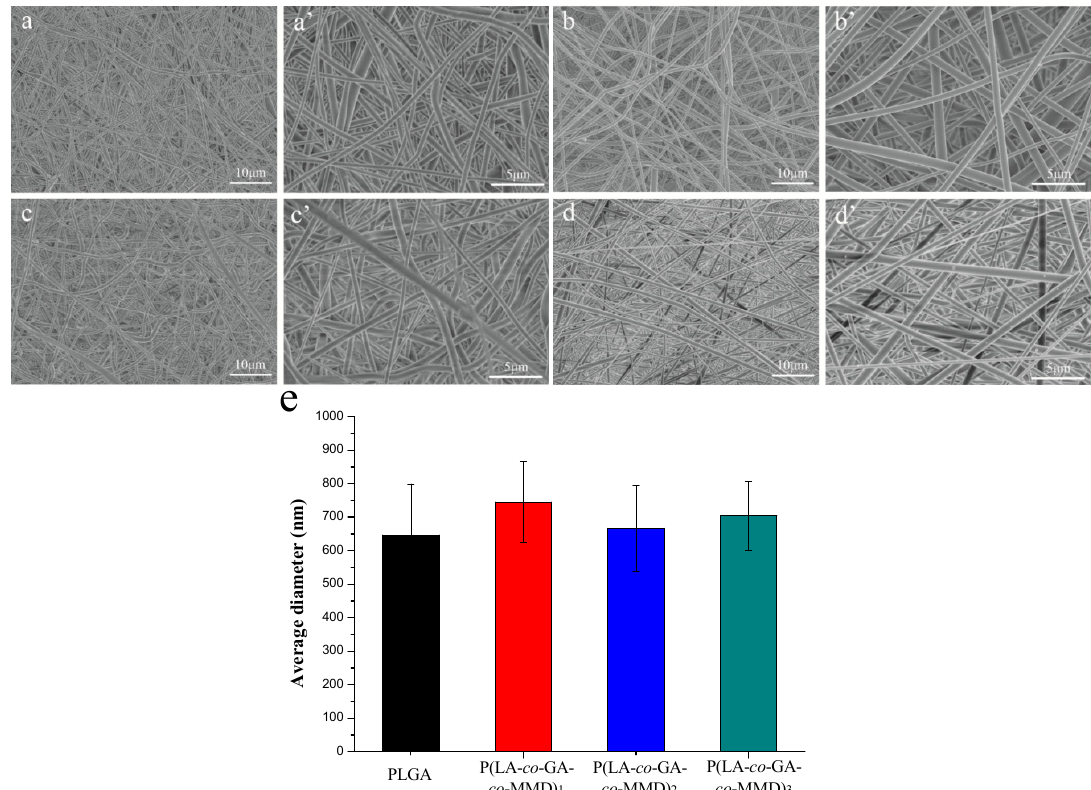
Figure 3. SEM of electrospun nanofibrous scaffolds: ( a and a’ ) PLGA; ( b and b’ ) P(LA- co -GA- co -MMD) 1 ; ( c and c’ ) P(LA- co -GA- co -MMD) 2 ; ( d and d’ ) P(LA- co -GA- co -MMD) 3 and ( e ) average diameters of electrospun scaffolds. (mean ± SD, n = 3).